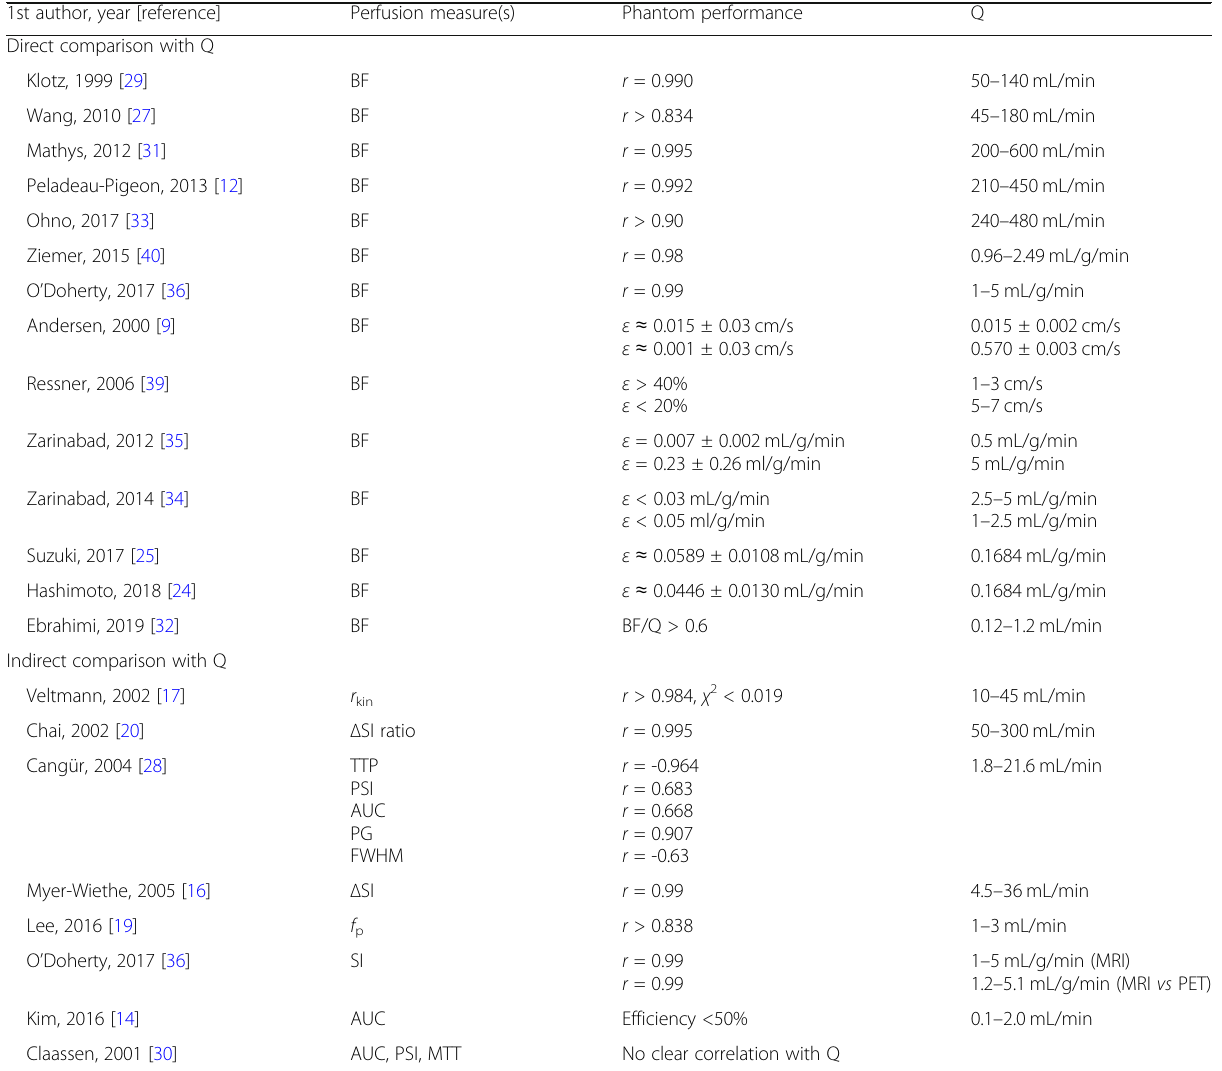
Table 5 Design and realisation of brain perfusion phantoms for quantitative perfusion imaging